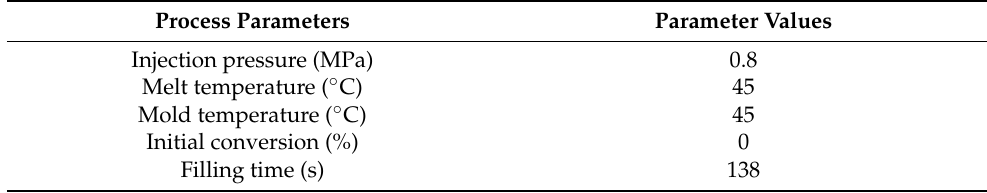
Table 3. The parameters of the filling process in Case